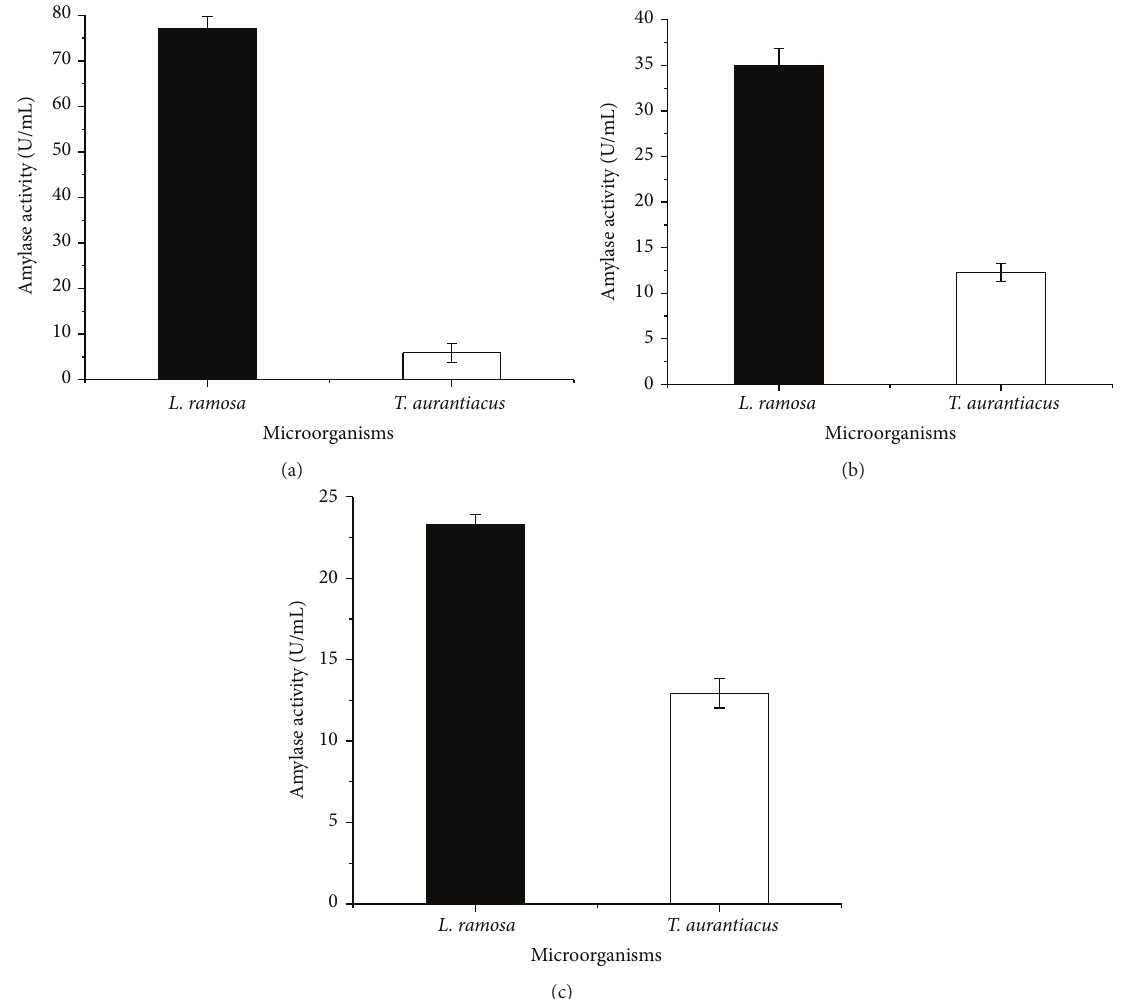
Figure 5: Enzymatic modifications of the corn starch molecule. (a) Quantification of dextrinizing activity using the iodometric method (reduction in the starch polymerization degree); (b) quantification of sugars and reducing ends using the DNS method; (c) quantification of glucose using the glucose/oxidase method (each data point was the average of two replicate determinations, and the error bars show the data